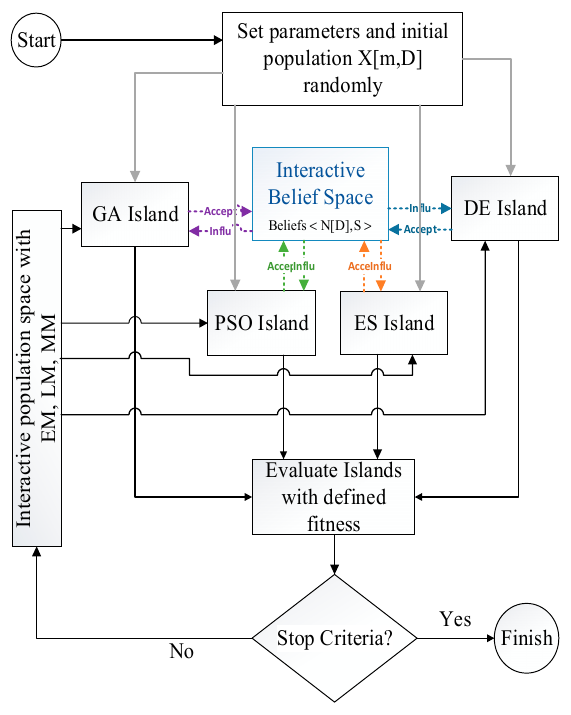
Figure 1. Flowchart of the MIC algorithm.